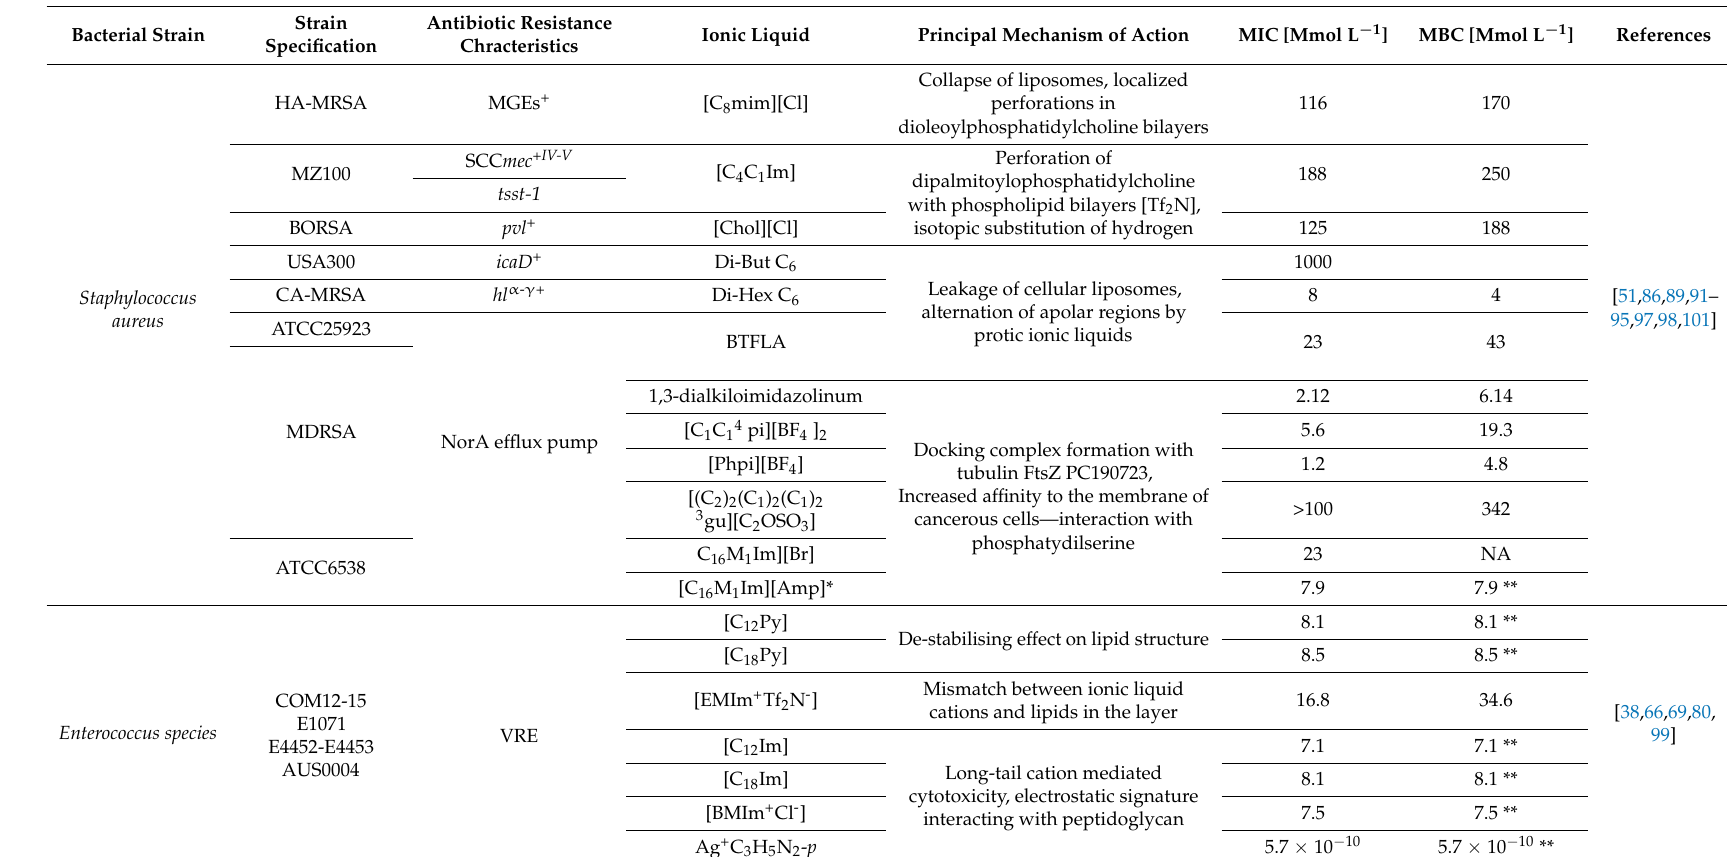
Table 2. Listing of bacterial priority strains including S. aureus , Enterococcus species , K. pneumoniae , Enterobacteriaceae and P. aeruginosa , antibiotic resistance mechanisms and ionic liquids showing the best effect in the treatment of